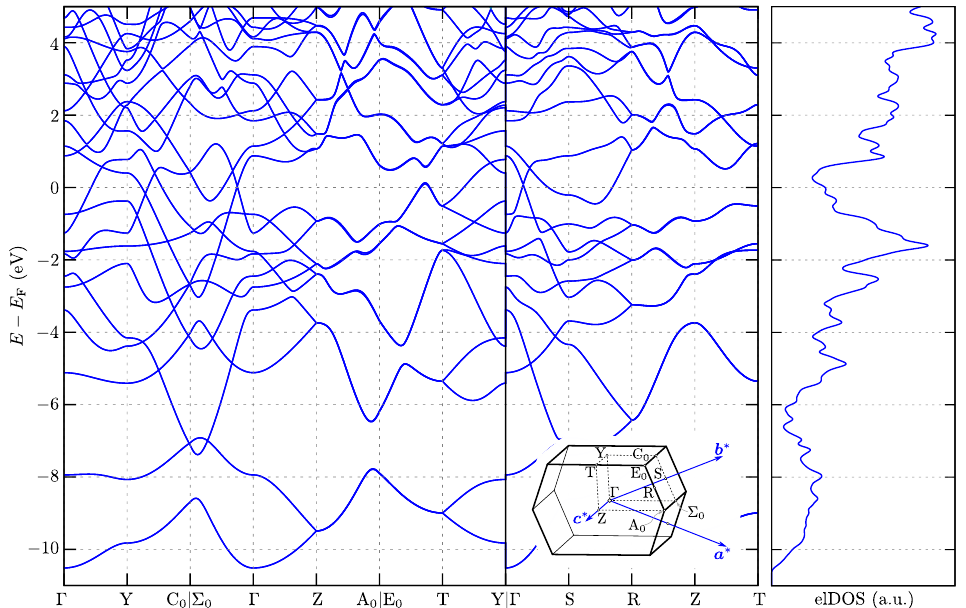
Figure 2. Electronic band structure and density of states (elDOS) of YAlSi with orthorhombic Cmcm symmetry. Inset presents Brillouin zone with high symmetry points for Cmcm